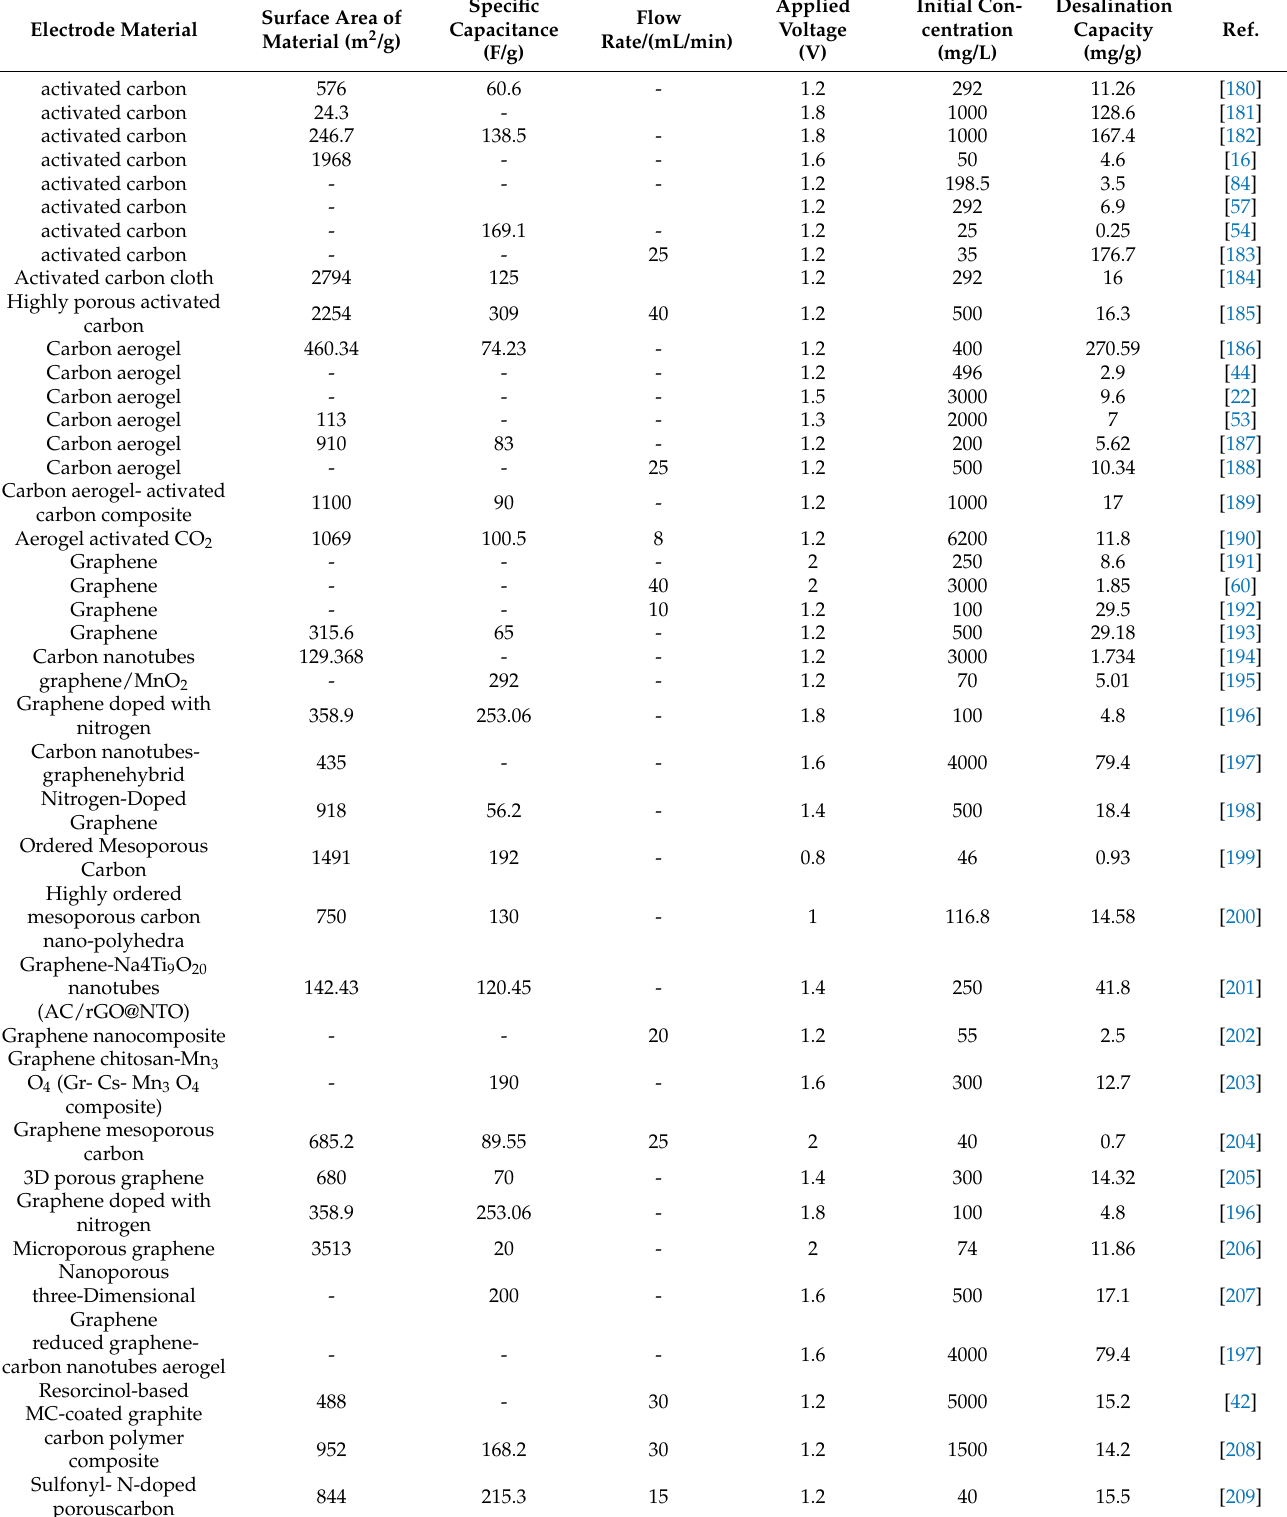
Table 3. Desalination performance of different material electrodes with CDI in the